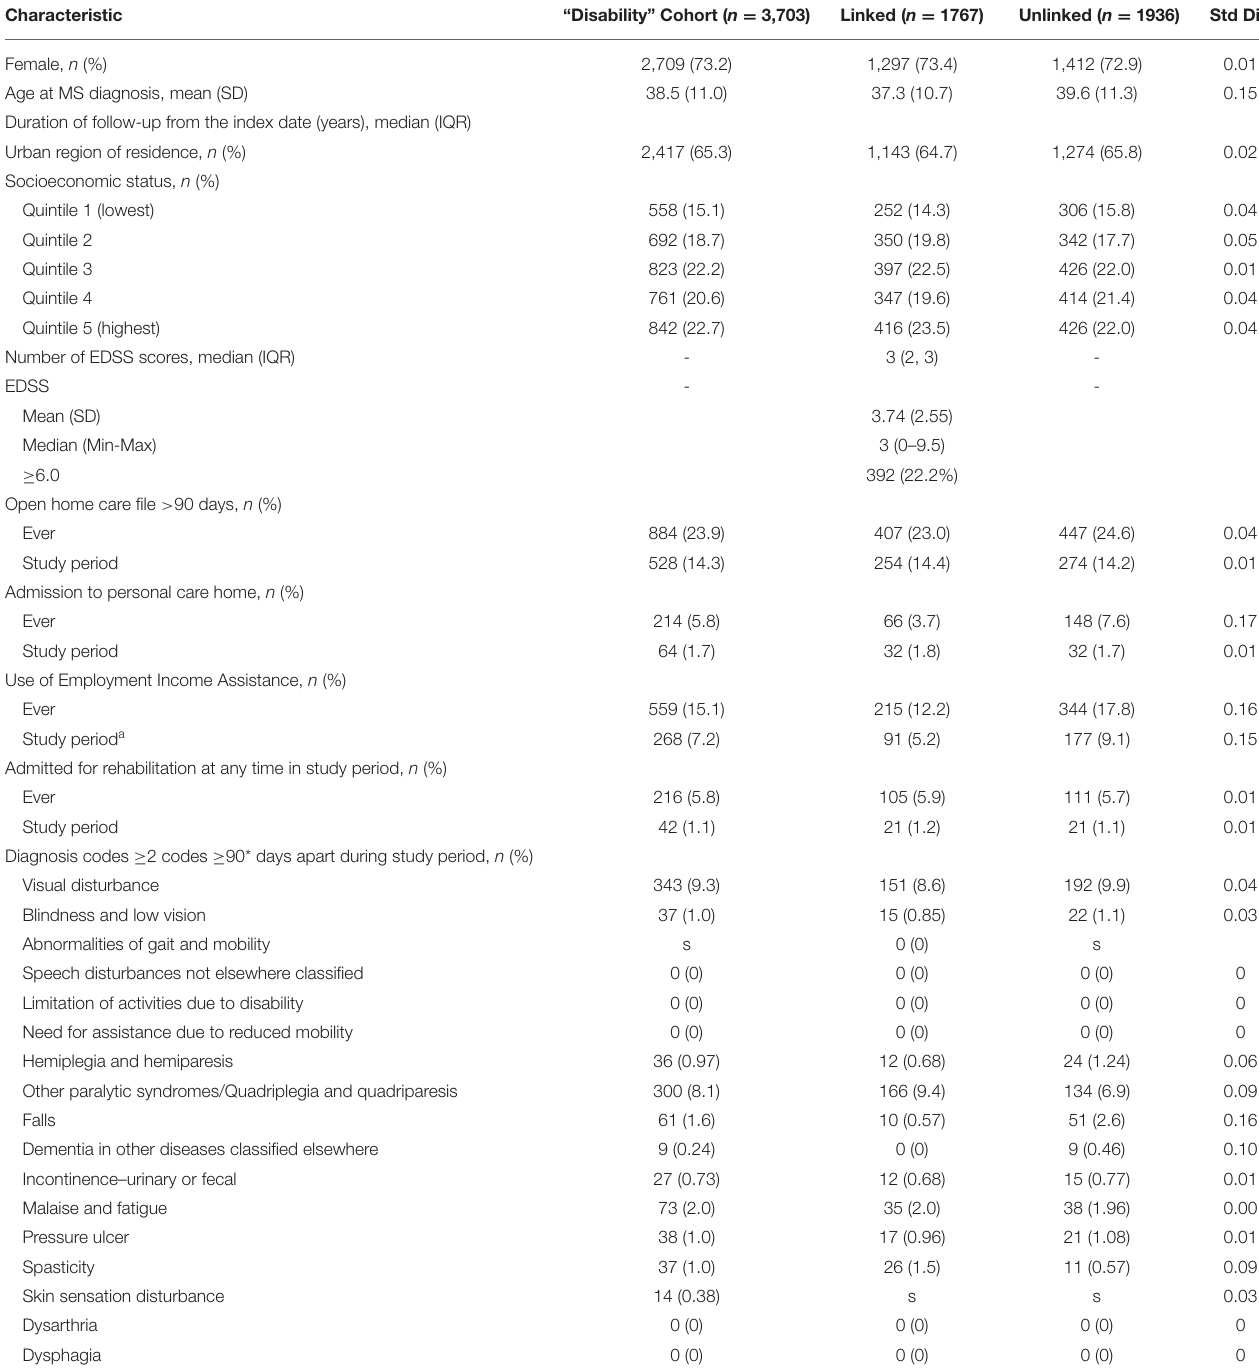
TABLE 1 | Characteristics of study